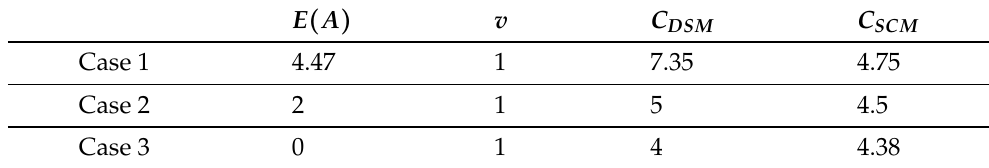
Figure 1. Example BDDs with the corresponding DSM Representations. Table 2. Results on the impact of